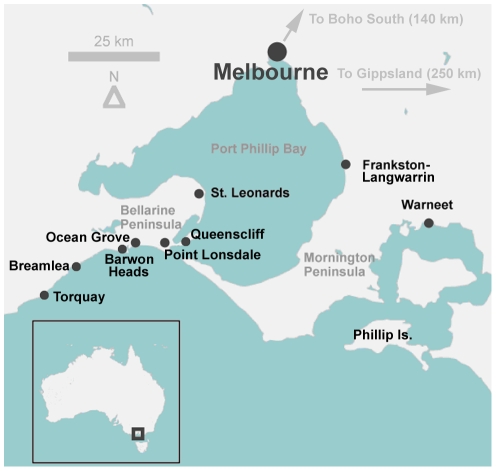
Map of central coastal Victoria, showing places referred to in the text or associated references.